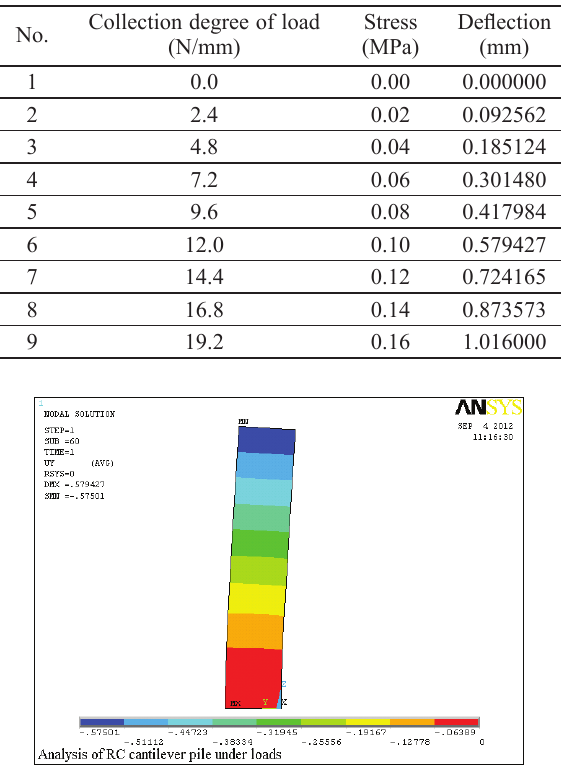
Fig. 5. Y-direction displacement contour of cantilever pile with steel bars under uniformly distributed with a